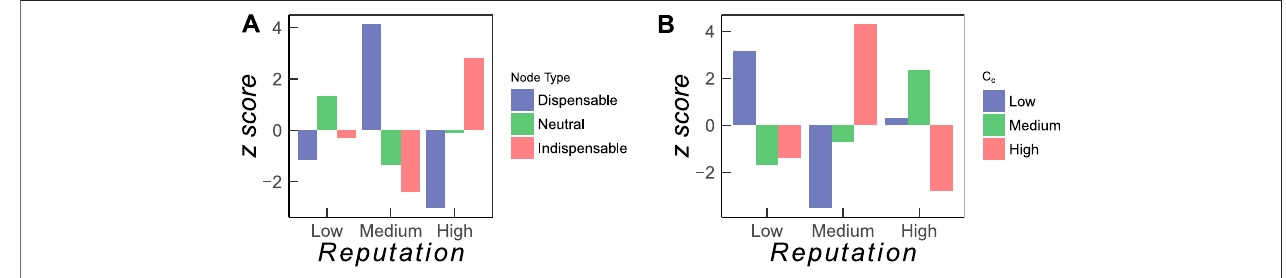
FIGURE 5 | Enrichment analysis for fi rms classi fi ed according to their reputation value. (A) Role of fi rms in maintaining control and (B) role of fi rms with respect to control contribution, C i .